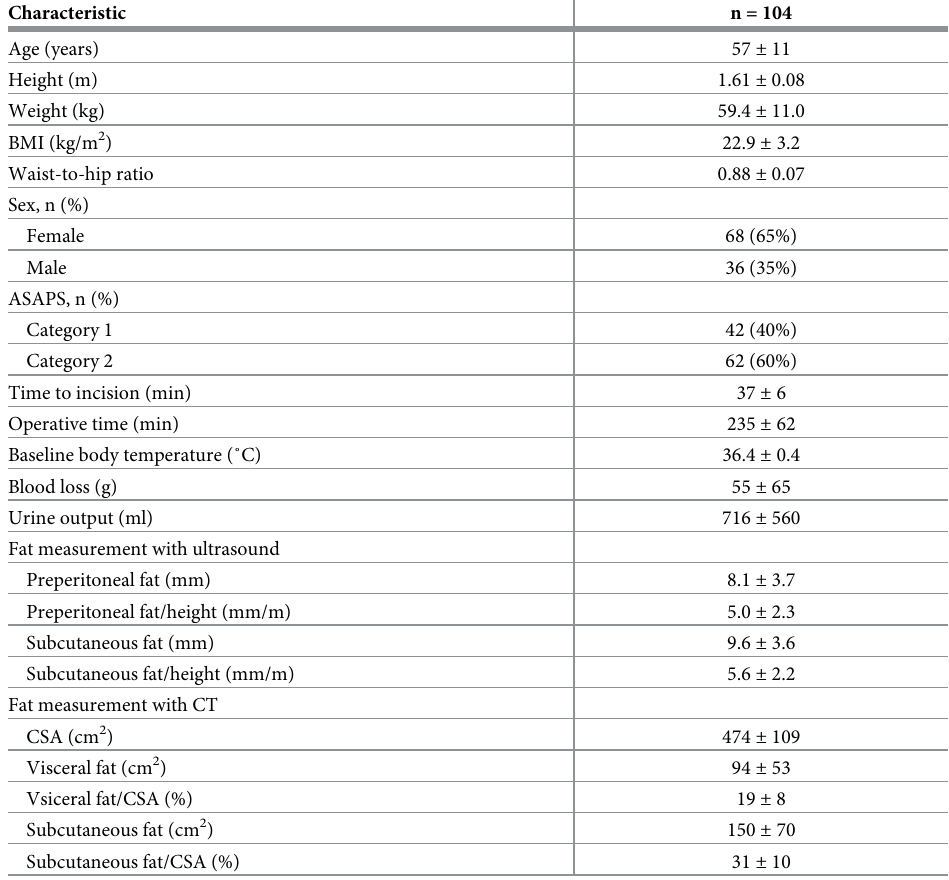
Table 1. Demographic and clinical